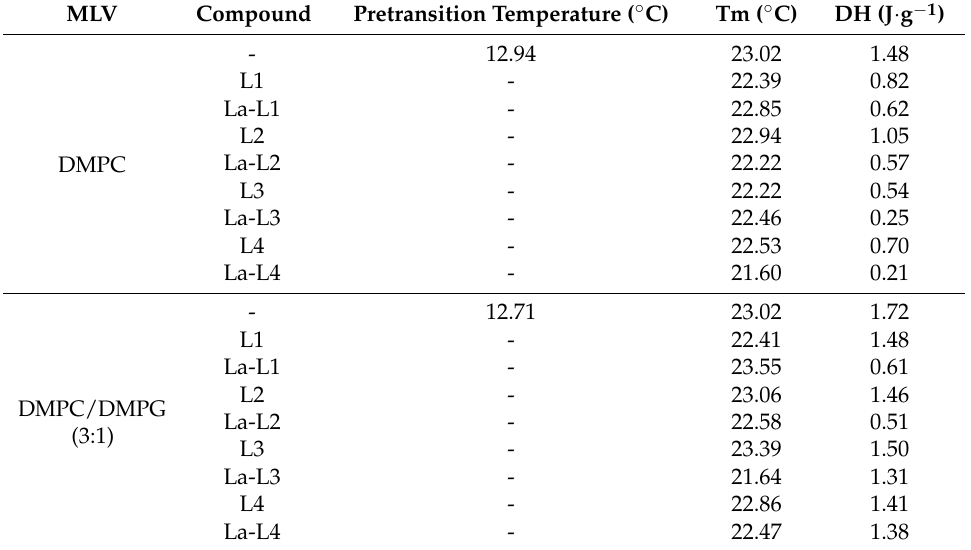
Table 3. Tm and enthalpy transition (DH) values of multilamellar vesicles (MLVs) formed by DMPC and DMPC:DMPG (3:1) before and after addition of ligands and La complexes at a 1:50 compound:lipid molar